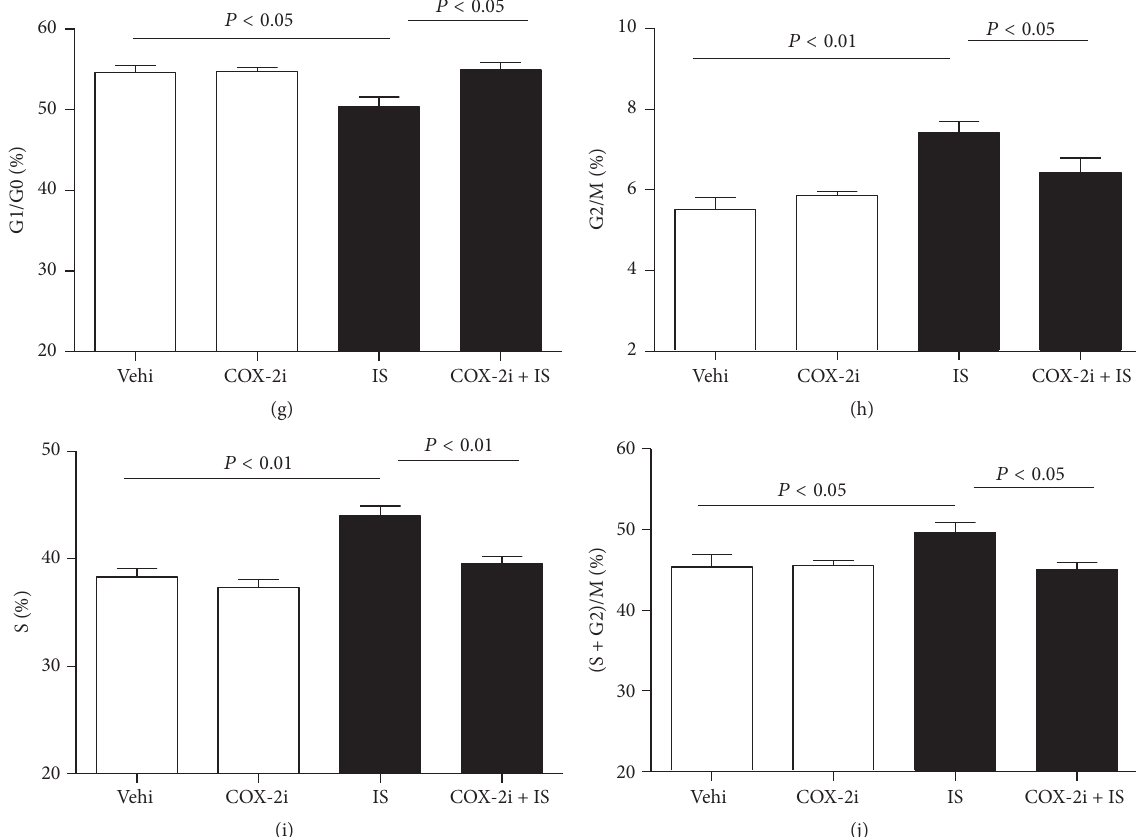
Figure 5: Effects of COX-2 specific inhibitor NS398 on cell cycle progression after IS treatment. The cells were treated with NS398 (10 𝜇 M) for 12h before IS (500 𝜇 M) administration. (a) qRT-PCR analysis of COX-2 after COX-2 inhibitor (NS398, 10 𝜇 M, and 20 𝜇 M) treatment in MCs. (b) Western blotting analysis of COX-2 expression after COX-2 inhibitor (10 𝜇 M and 20 𝜇 M) treatment in MCs. (c–f) Representative images of cell cycle following the treatments of IS and/or COX-2 inhibitor. (g–j) Percentage of cells at G1/G0 (g), G2/M (h), S (i), and (S + G2)/M (j) phases following the treatments of IS and/or COX-2 inhibitor. Values are means ± SD; 𝑛 = 6 in each